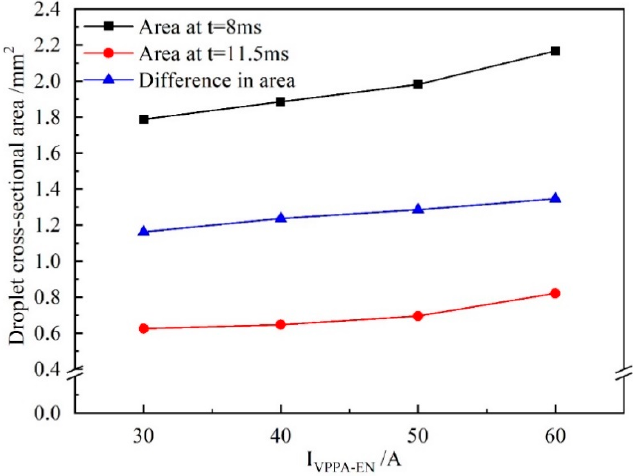
Figure 9. The difference in droplet cross-sectional area between 8 and 11.5 ms for varied I VPPA-EN and I MIG-EN fixed at 70 A.